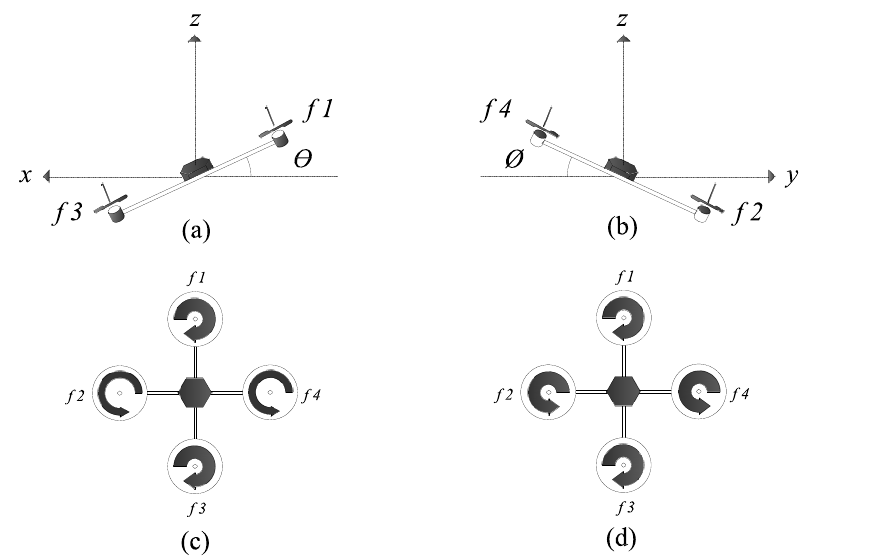
Figure 2. Quadrotor’s possible movements. ( a ) Movement along with the x -axis. ( b ) Movement along with the y -axis. ( c ) Orientation with respect to the z -axis ( ψ angle). ( d ) Movement along with the z -axis